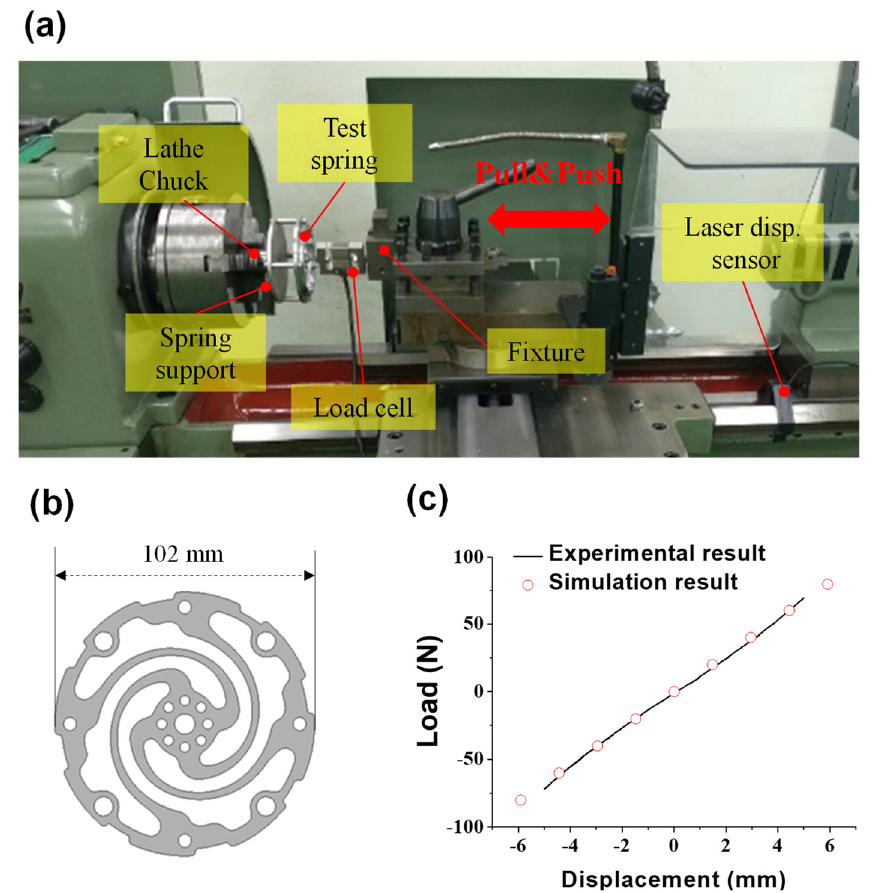
Figure 10. Static load-displacement tests of flat spiral spring: ( a ) experimental set-up for the stiffness test, ( b ) spring for analytical validation, and ( c ) measured and predicted force-displacement curves.